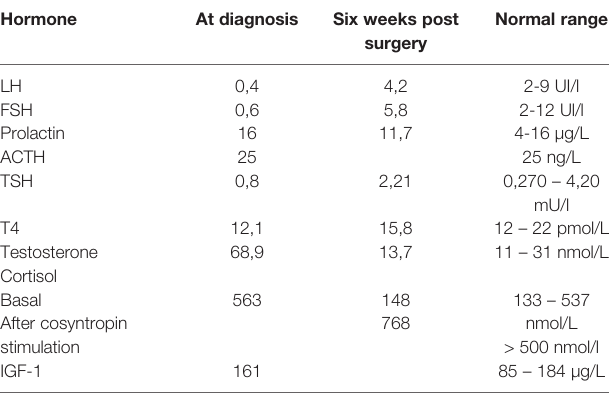
TABLE 1 | Initial hormonal